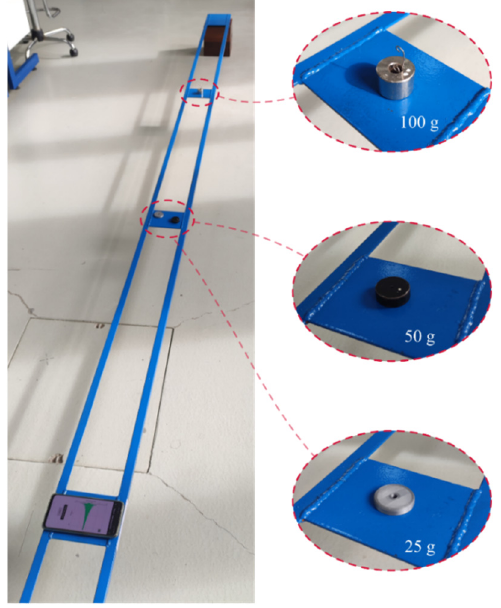
Figure 13. Lab beam and added masses used to simulate damage.